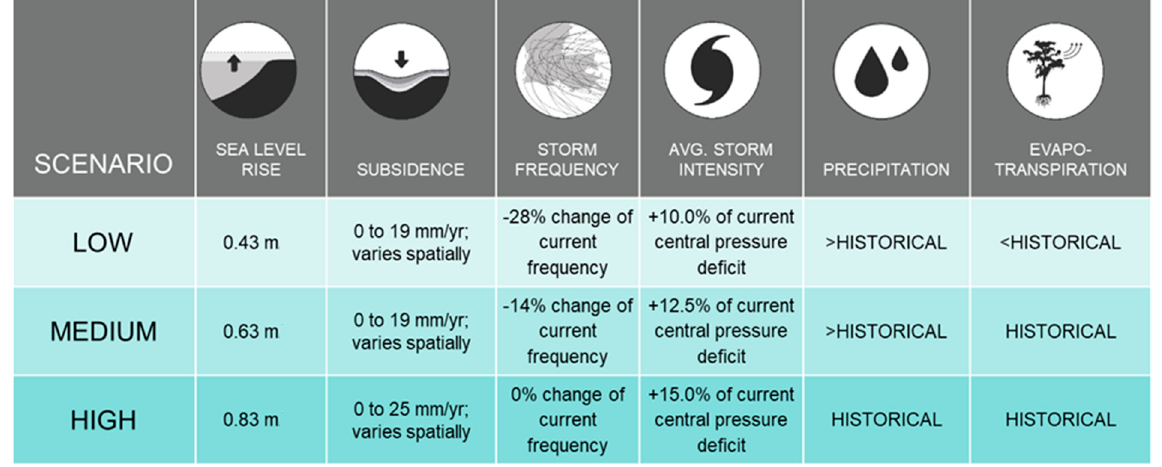
Figure 2. Environmental scenarios used in the 2017 Coastal Master Plan.